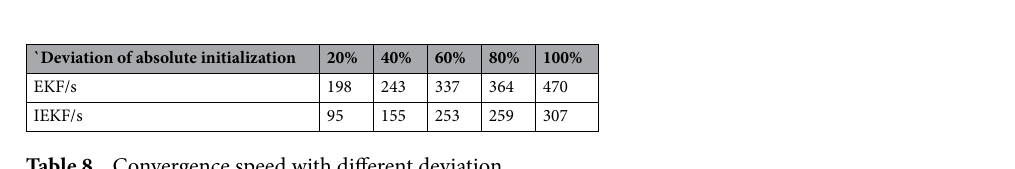
Table 8. Convergence speed with different deviation.